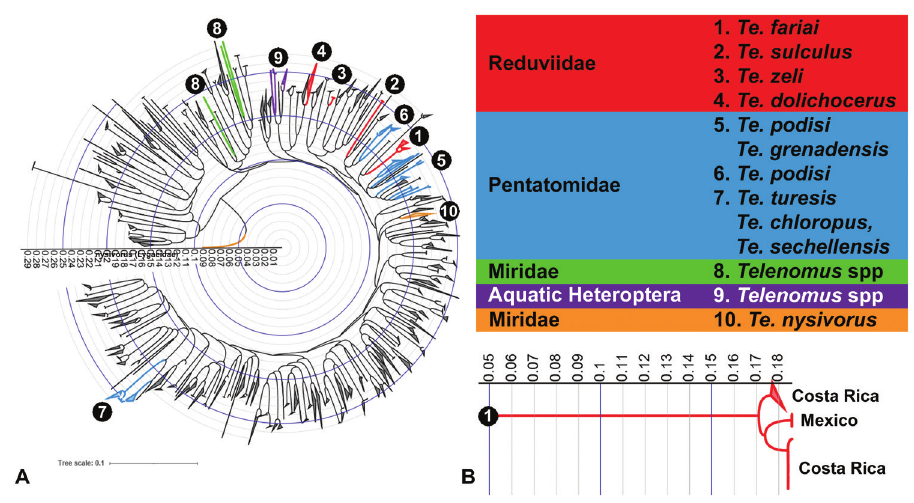
Figure 16. A neighbor joining tree of all Telenomus COI sequences in BOLD with heteropteran host associations annotated by color B pruned branch of Te. fariai